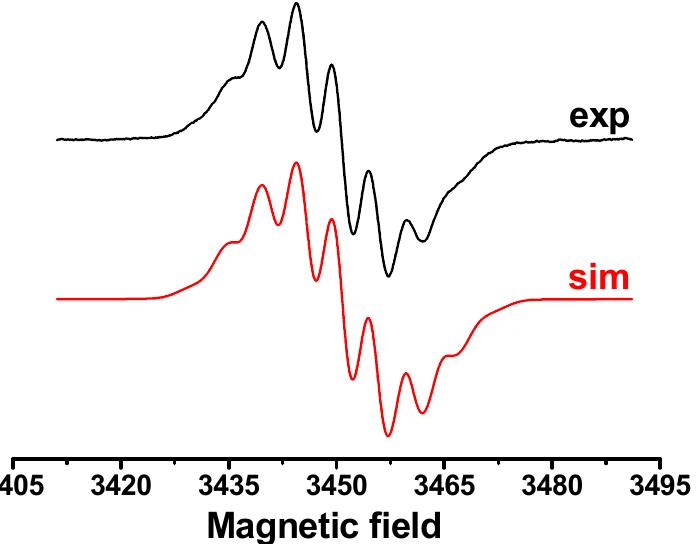
Figure 6. The EPR spectrum (black) of complex generated by cathodic reduction of [(dpp-BIAN)Fe II I 2 ] in CH 2 Cl 2 at − 1.65 V vs. Fc/Fc+ and its simulation (red) with g = 2.0027, 2:a N = 4.8 G, and 4:a H = 4.7 G.